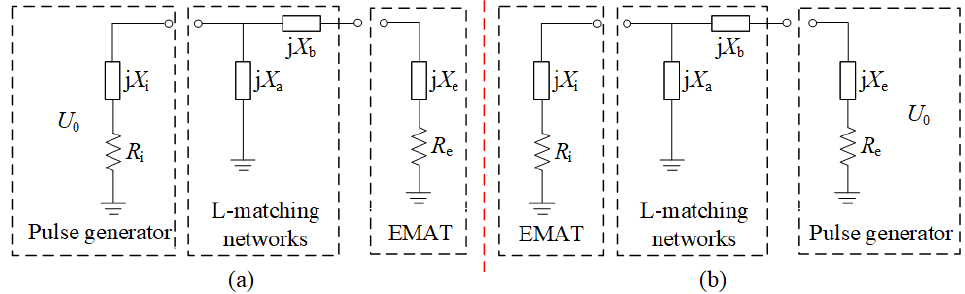
Figure 1. EMAT excitation equivalent circuit model ( a ) Impedance matching method I ( Q > 0) II ( Q < 0) ( b ) Impedance matching method III ( Q > 0) IV ( Q < 0).